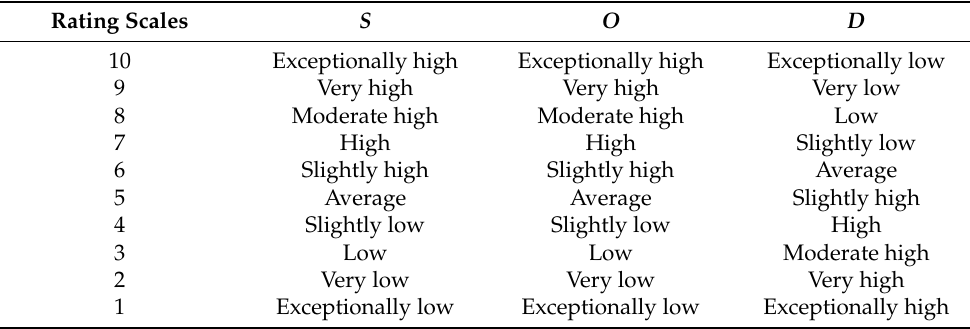
Table 1. The typical rating scales of severity ( S ), occurrence ( O ), and detection ( D ). Rating Scales S O D 10 Exceptionally high Exceptionally high Exceptionally low 9 Very high Very high Very low 8 Moderate high Moderate high Low 7 High High Slightly low 6 Slightly high Slightly high Average 5 Average Average Slightly high 4 Slightly low Slightly low High 3 Low Low Moderate high 2 Very low Very low Very high 1 Exceptionally low Exceptionally low Exceptionally